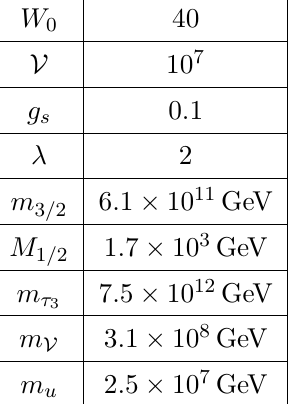
Table 1 . Benchmark spectrum for Kähler moduli inflation. The gaugino mass M from (3.8) with ω = 0 . 01 and τ